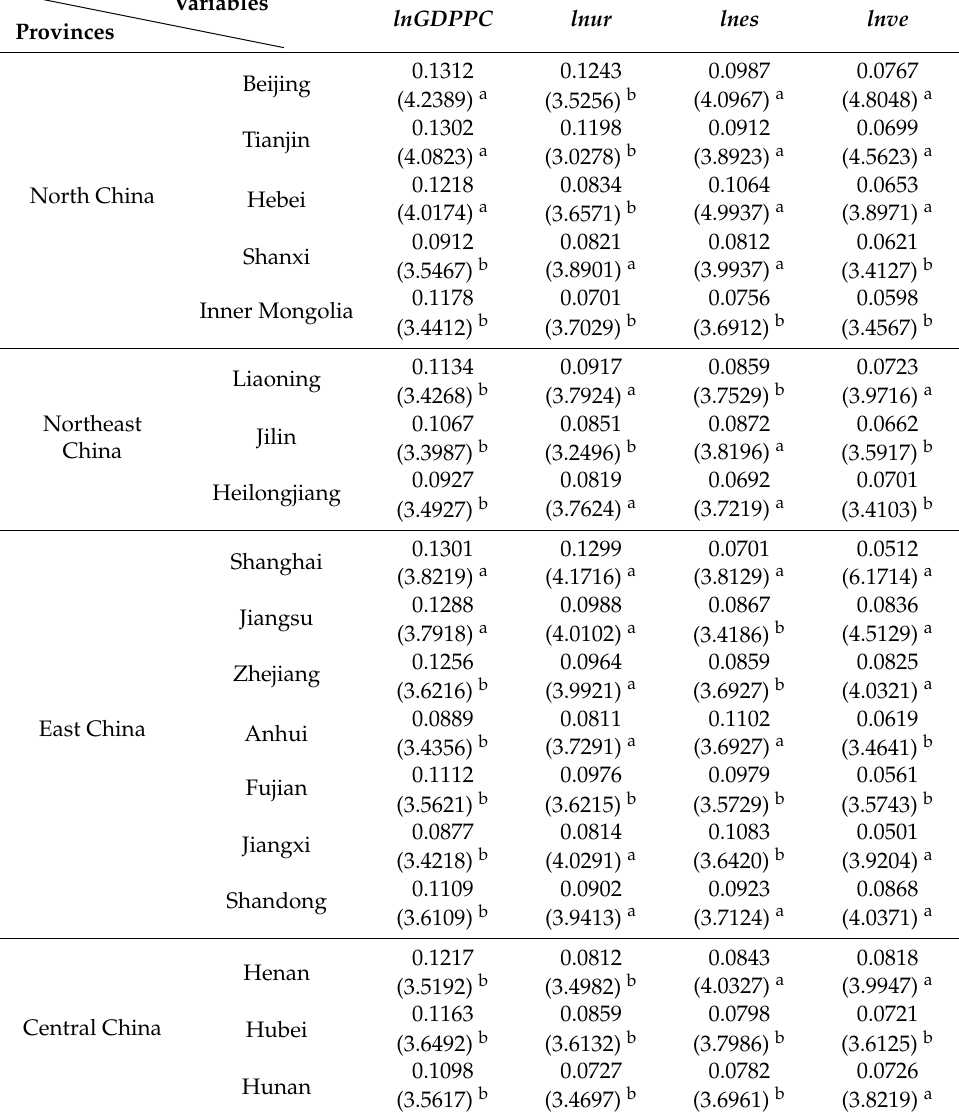
Table 8. The evaluated coe ffi cients for the panel data